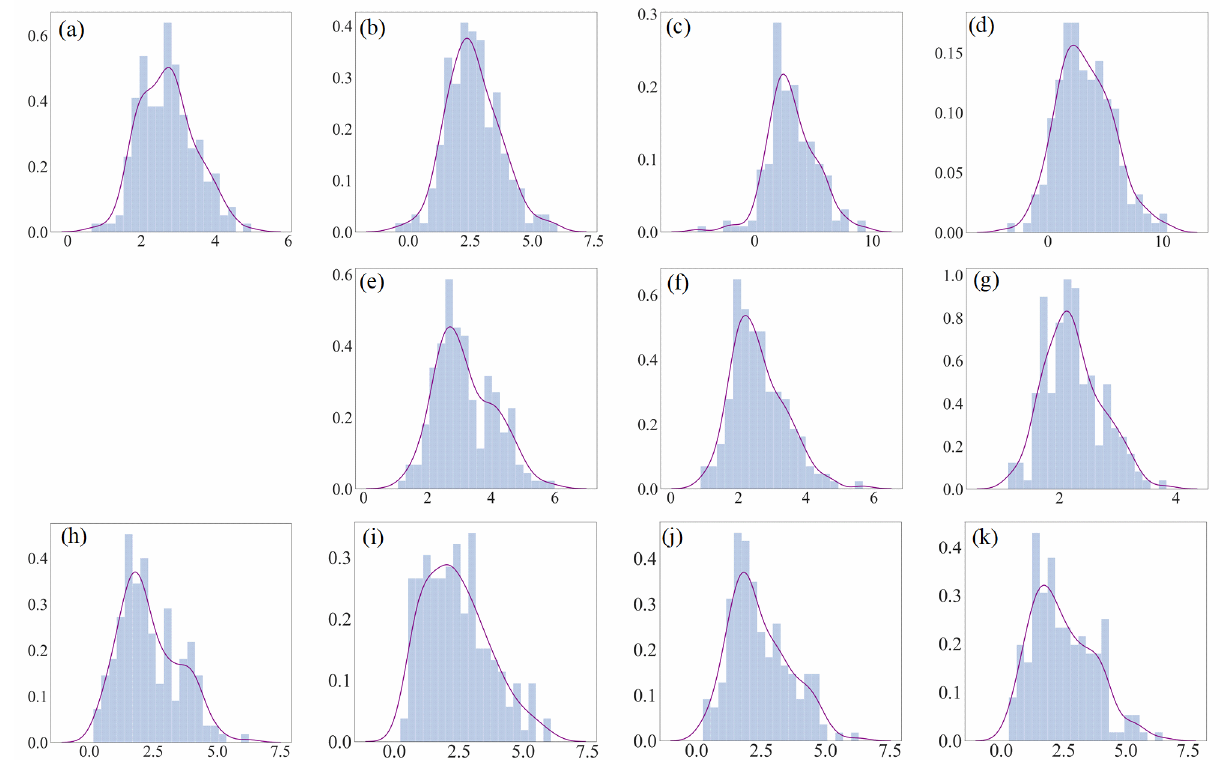
Figure A3. Changes in PDF during the successive adjustments of wind speed based on the GCM MPI simulations at the Naqu site. The upper row indicates the control observations (( a ), 1955–1969)) and the calibrated results of the three adjustments ( b – d ). The center row ( e – g ) indicates the observations for validating the calibrated results for the corresponding projection periods. The bottom row ( h – k ) indicates the raw GCM simulations in the corresponding periods. The first column: control period (1955 – 1969); the second to fourth columns: the first (1970 – 1984), second (1985 – 1999) and third (2000 – 2014) adjustments, respectively. The solid line indicates a distribution fit to the data.